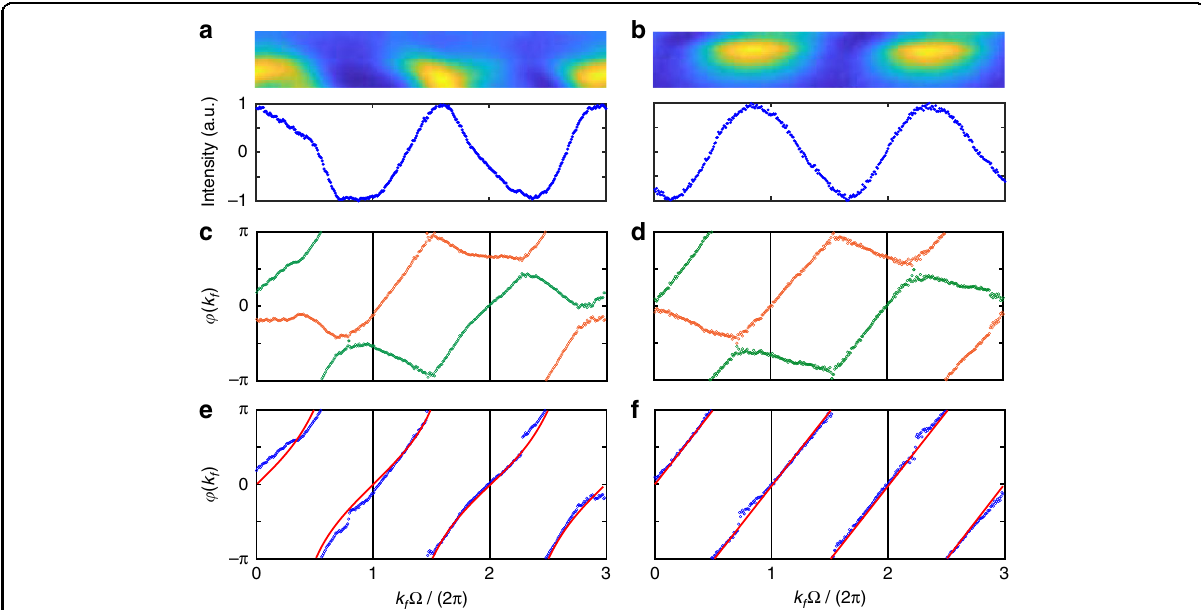
Fig. 4 Extraction process of the Zak phase under condition of V1 < V2. a , b The normalized maximum intensities S 2 of each vertical slice (the lower panels) extracted from the chosen bands (the upper panels) in Fig. 3(a) (red arrow) and Fig. 3(b) (blue arrow), respectively. c , d The corresponding calculated arguments φ ( k f ) from ( a ) and ( b ) based on Eq. (11). e , f The selected arguments (blue circles) that satisfy the periodicity of 2 π / Ω from ( c ) and ( d ), in comparison with the theoretical values of arg( G ) (red lines),